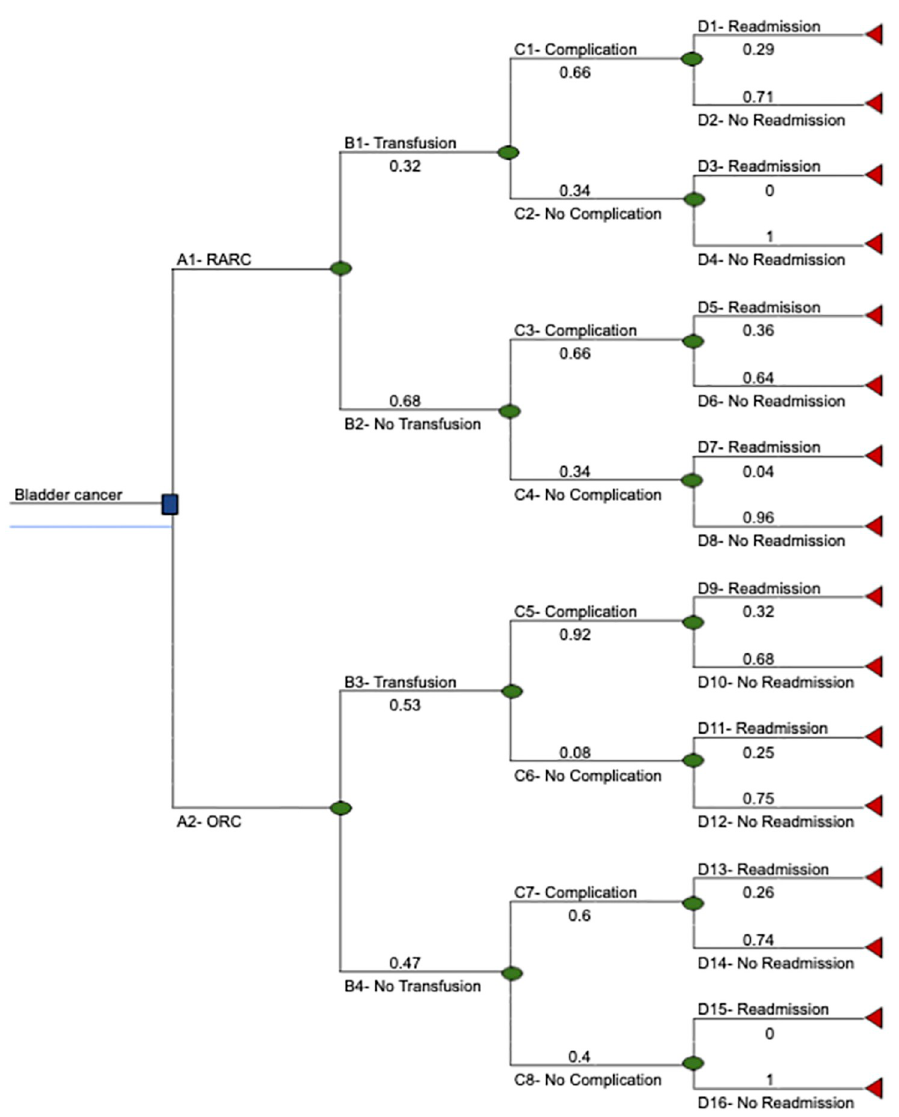
Fig 1. Three-fold decision tree of RARC and ORC including conditional probabilities of transfusion, complications and readmission.